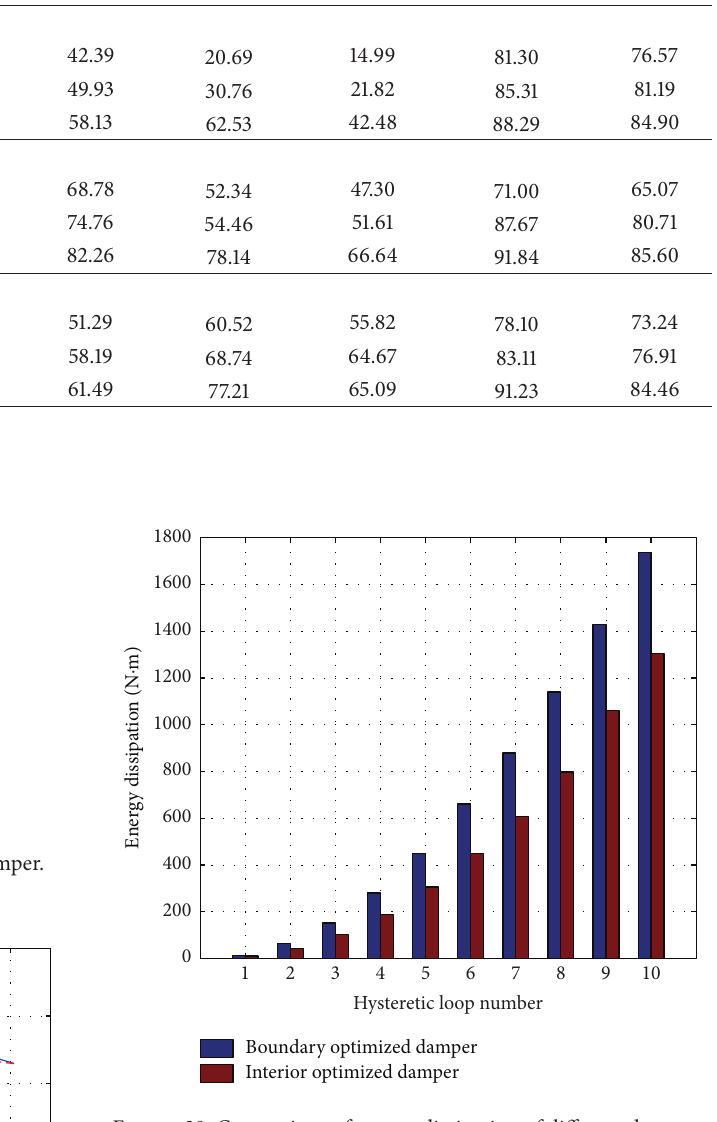
design, a generalized displacement-based design procedure of hysteretic damped braces has been proposed by Mazza and Vulcano [28, 29], which proportions hysteretic damped braces to attain a designated performance level of an existing framed structure. On the basis of this research, the main steps of the proposed design procedure of frame with